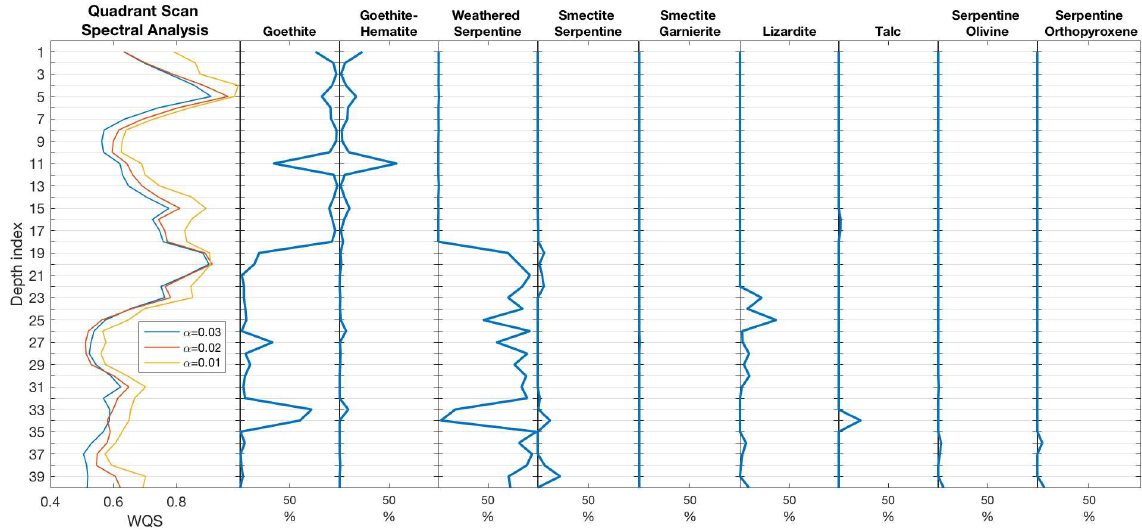
Figure 10. NGO_PB4 drill-hole: The WQS analysis in comparison with the abundance percentage of different minerals obtained with Corescan. The left panel is the WQS results from the spectral data using three different values of α , peaks indicate lithological, alteration and weathering boundaries. The rest of the panels show the abundance percentage of different minerals along the drill-hole.